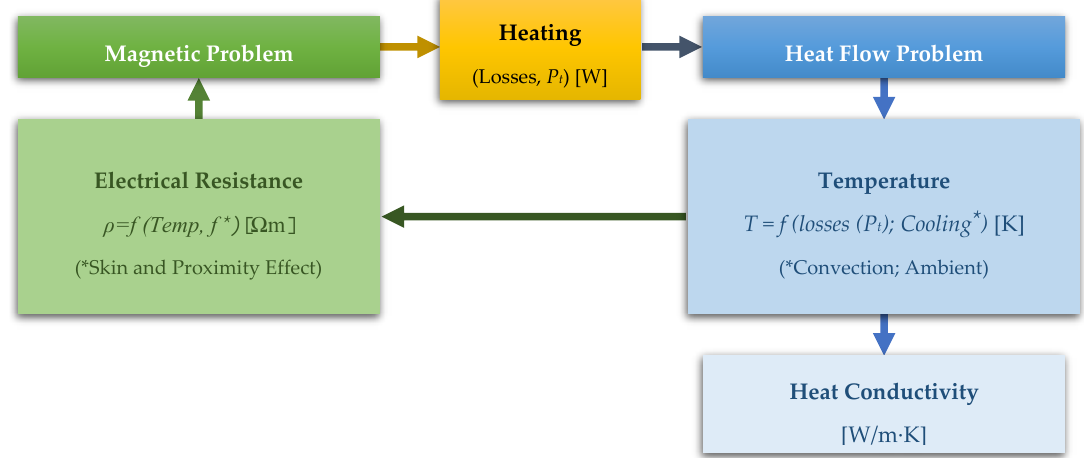
Figure 13. Simulation of the physical process.